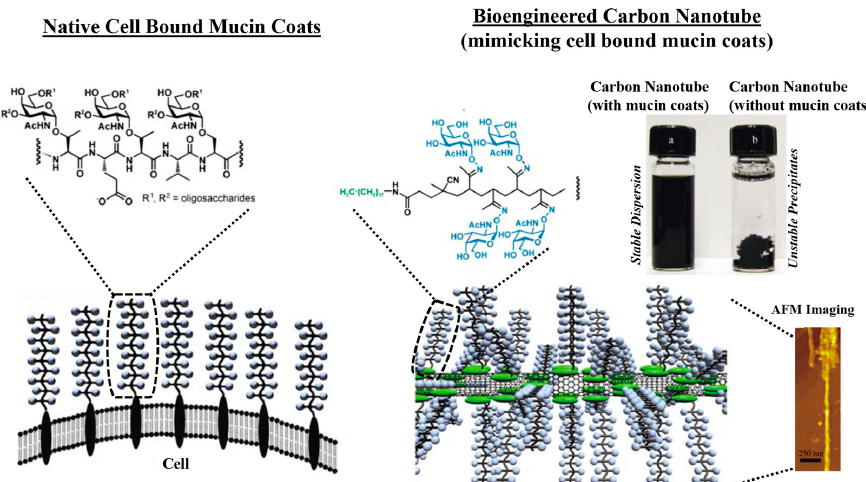
Figure 6. A comparison of native cell bound mucin coats with biomimetic carbon nanotubes possessing cell bound mucin coats. The bioengineered carbon nanotubes mimics the native cell bound mucin functional property, and can be used in preventing non-specific protein binding (antibiofouling), or immobilizing specific functional molecules to CNT via specific biomolecular recognition with mucin chains, or as coatings for developing stable dispersions. Reprinted with permission from Reference [148]. Copyright © 2004, Wiley-VCH Verlag GmbH & Co. KGaA,